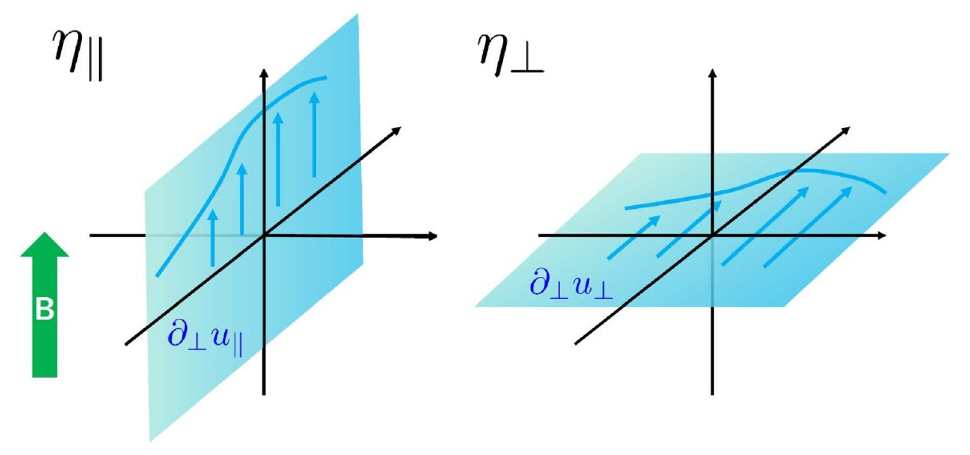
Figure 2 . Shear deformations in and out of planes with respect to the magnetic flux lines.